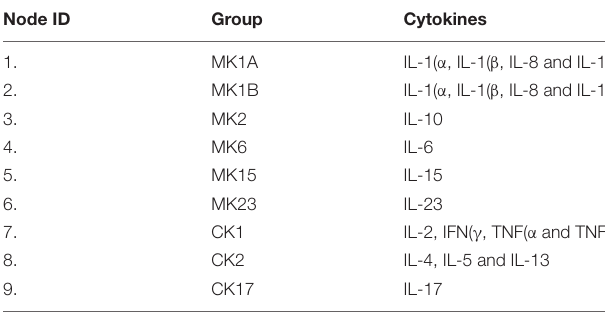
TABLE 2 | Aggregated Cytokine